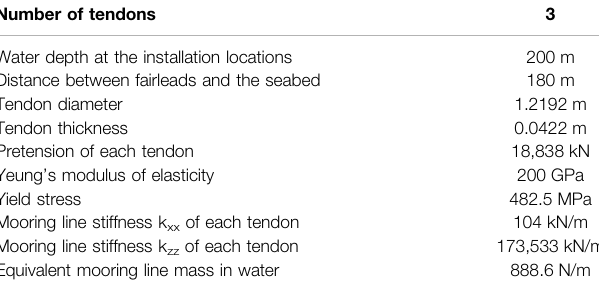
TABLE 2 | Mooring properties of the hybrid structure. Number of